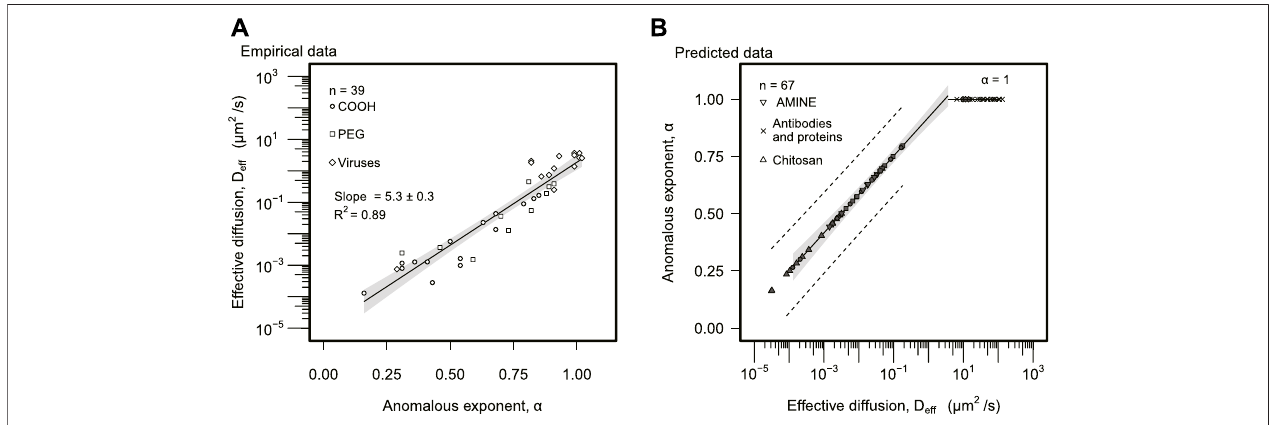
FIGURE 2 | Effectivediffusion and anomalousexponent analysis. (A) Effective diffusion wasplotted as afunction ofthe anomalousexponent. Thesolid linerepresents the regressionmodel.Thegrayarearepresentsthe95 % con fi denceinterval.Statisticallysigni fi cantslopeand R 2 oflinearregressionaredisplayed. (B) Theanomalousexponentwas predictedbasedonthemodelfoundempiricallyin (A) .Thesolidlinedesignatesthepredictedlinearmodel.Thegrayarearepresentsthe95 % con fi denceintervalofthepredicted linear model. The dashed line represents a 95 % prediction interval (A,B) , distinguished particle types are represented in the legend of both